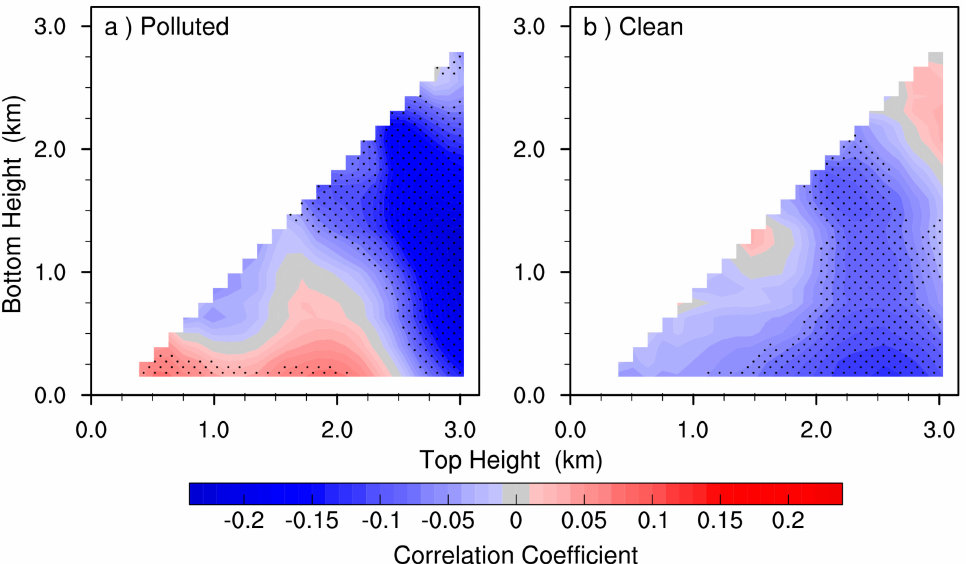
Figure 8. The correlation coe ffi cient distribution between normalized ground-level PM 2.5 and height-revolved VWS under ( a ) polluted and ( b ) clean conditions in Beijing. Gray dots indicate the Pearson correlation coe ffi cient that is statistically significant at the 90% confidence level. The X and Y axes represent the top and bottom heights of the VWS bulk,